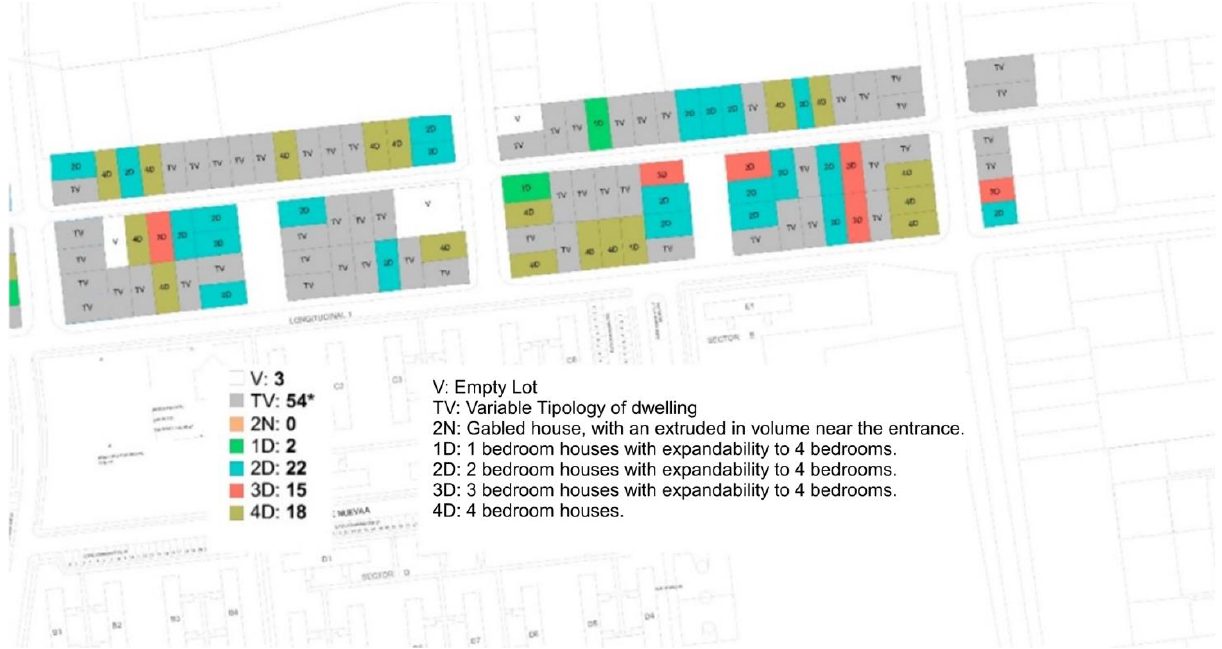
Figure A7. Dwellings urban distribution by typology —part 1 (authors’ own preparation).